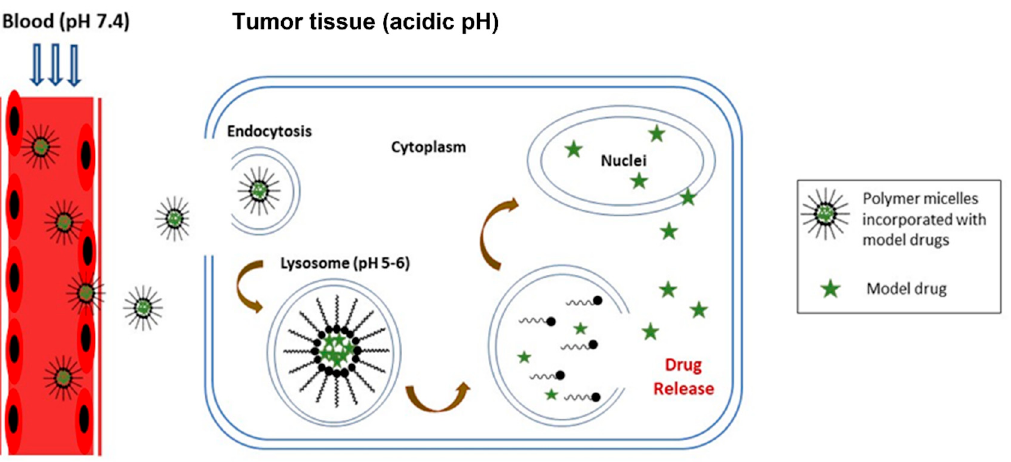
Figure 13. Illustration of doxorubicin (DOX) drug delivery system with PU micelles containing hydrazone linkage. Inside the blood (pH 7.4), the drugs remain retain inside the lysosome. When it reaches to the tumor tissue cells (pH 5.0–6.0), the hydrazone linkage hydrolyzes and breaks the lysosome formation, hence the drug is released inside the tumor tissue cells [103,105].